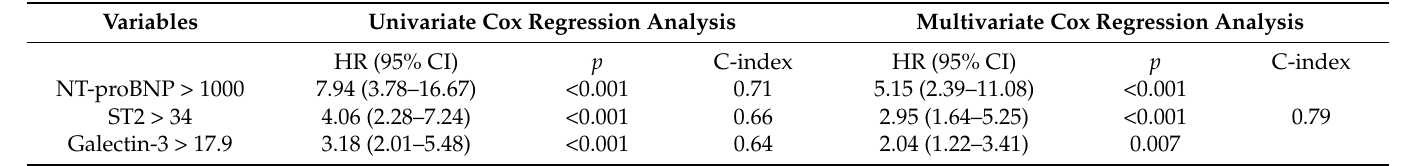
Table 3. Predictive value of high NT-proBNP, galectin-3, and ST2 serum levels. Variables